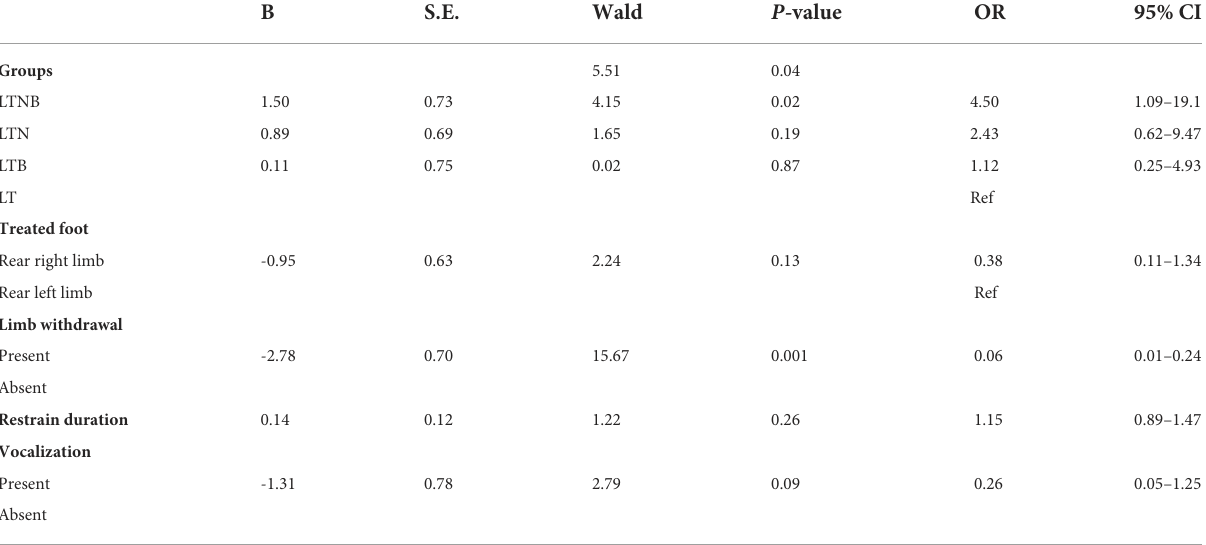
TABLE 7 Final logistic regression model showing the odds ratios of lameness recovery between the treatment groups and other associated factors at day 28 after treatment.